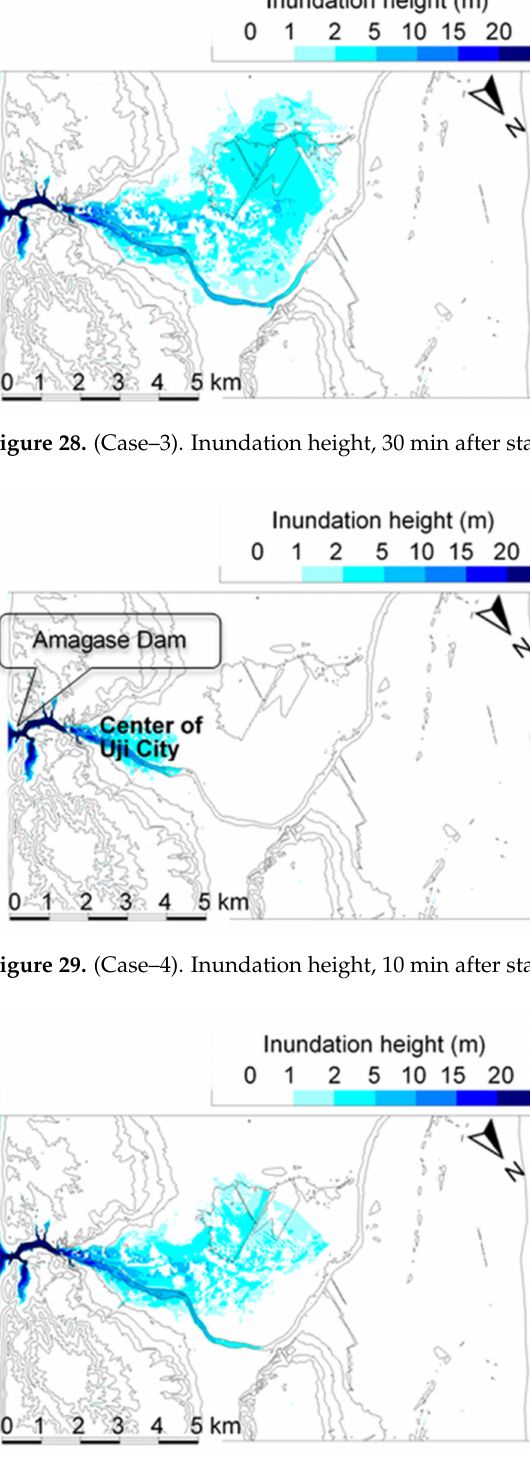
Figure 30. (Case–4). Inundation height, 20 min after start of the